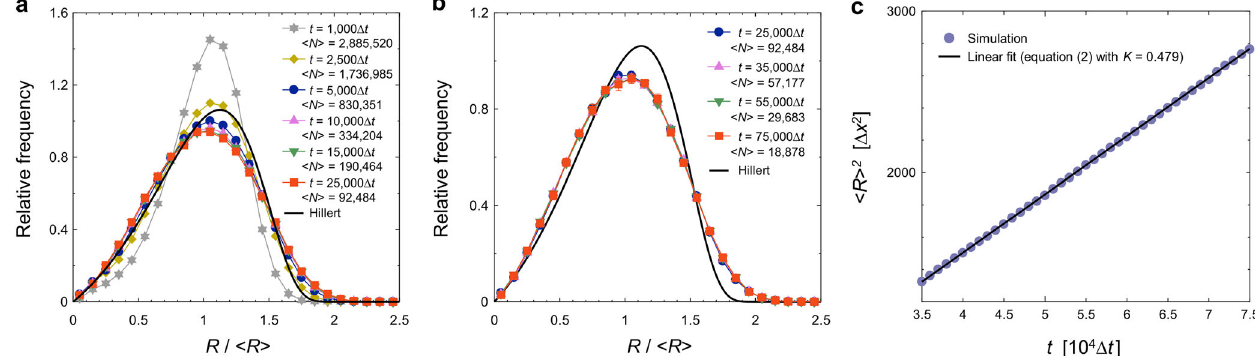
Fig. 2 Investigation of steady-state ideal grain growth behavior. a , b Grain size distributions during a transient and b steady-state regimes. c Temporal variation of the squared average radius during the steady state regime. In all panels, numeric data points are given as the average of three replicated simulations for 2560 3 -point systems, with error bars representing the standard deviation. For most of the data points, the error bars are smaller than the